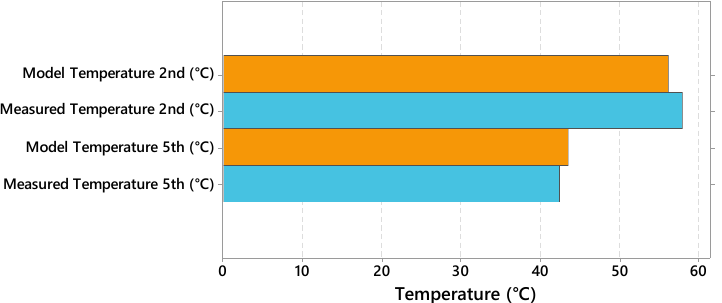
Figure 16. Comparison between the model and measured temperature for 25% voltage harmonic distortion of 2nd- and 5th-order harmonics.